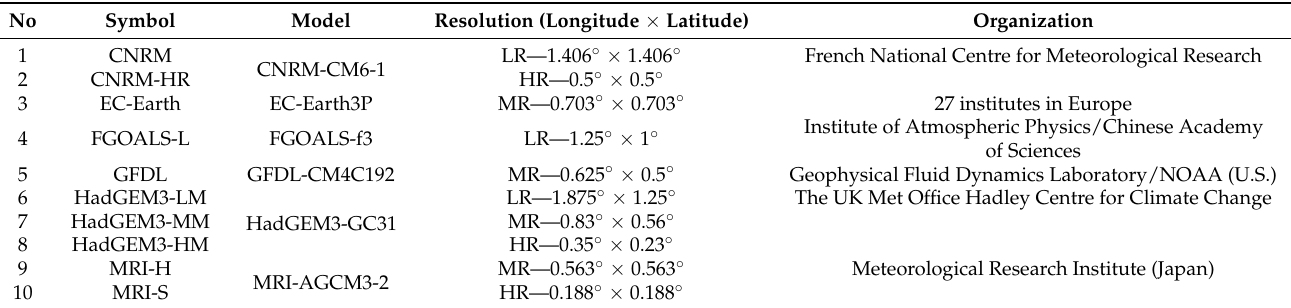
Table 1. Summary of the GCMs used in this study from the CMIP6 HighResMIP experiments. LR, MR and HR represent low, medium and high resolutions,